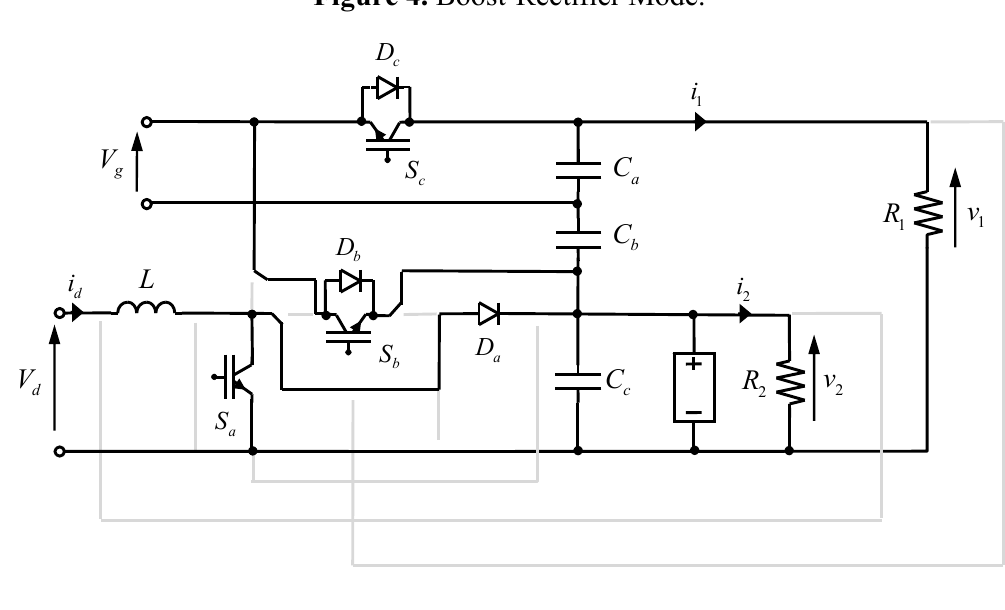
Figure 4. Boost-Rectifier Mode.